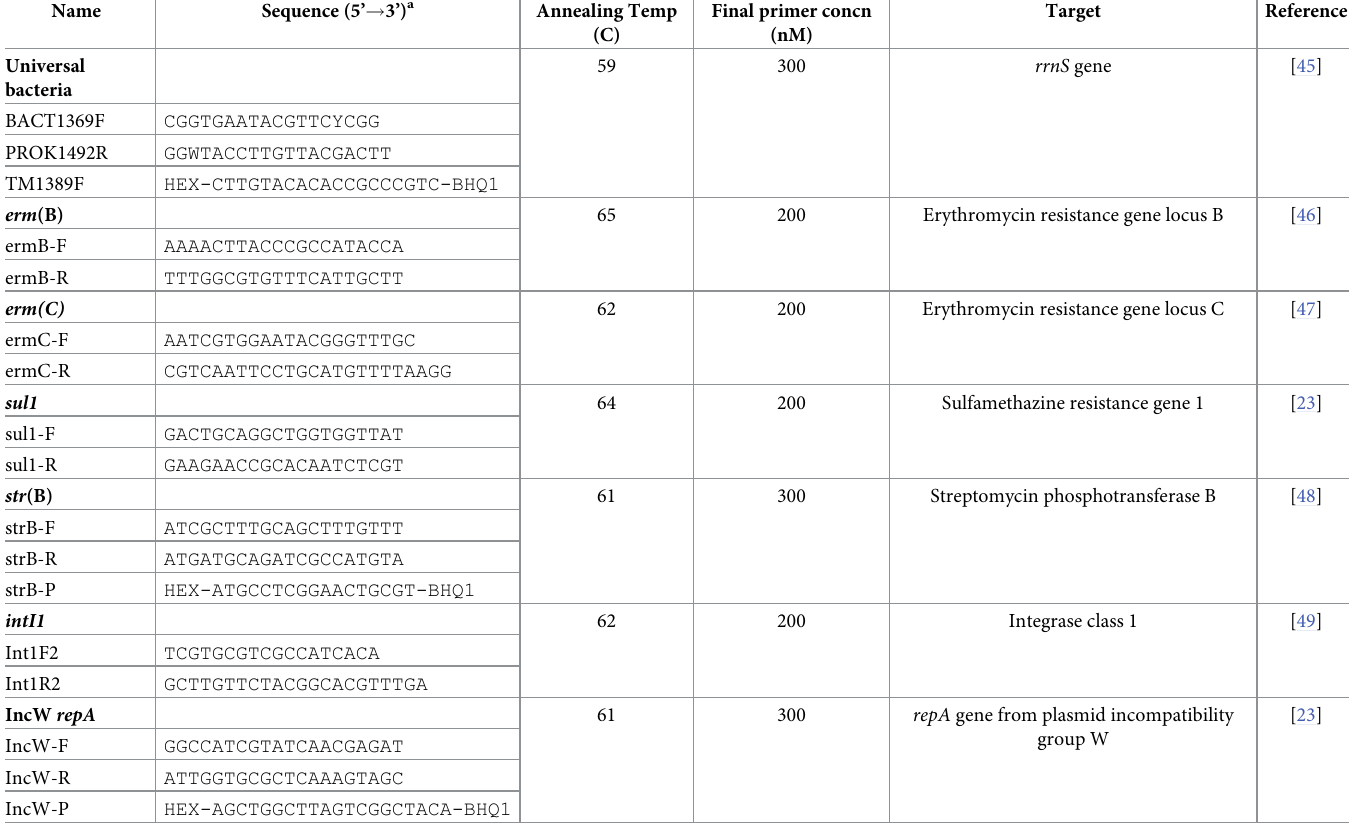
Table 1. qPCR primers and probes used in this